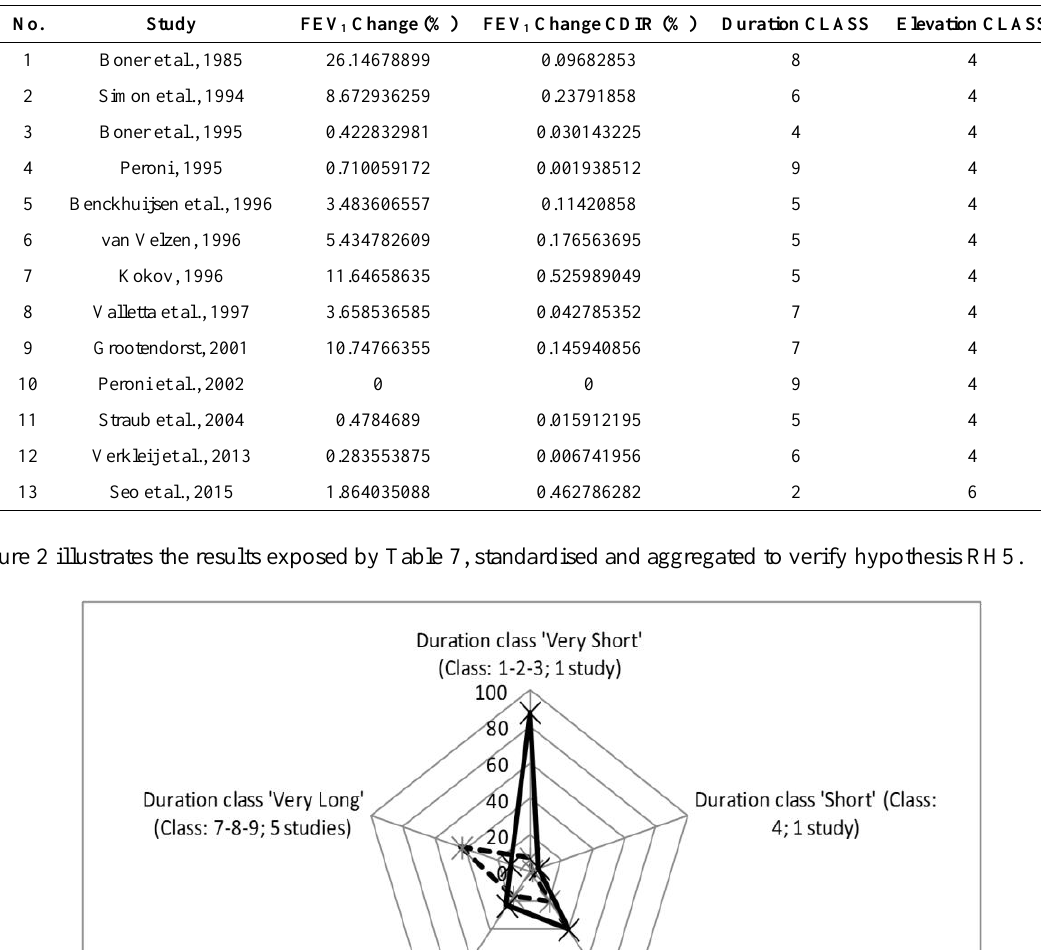
Table 7. FEV 1 Change % and FEV 1 Change % CDIR for young people